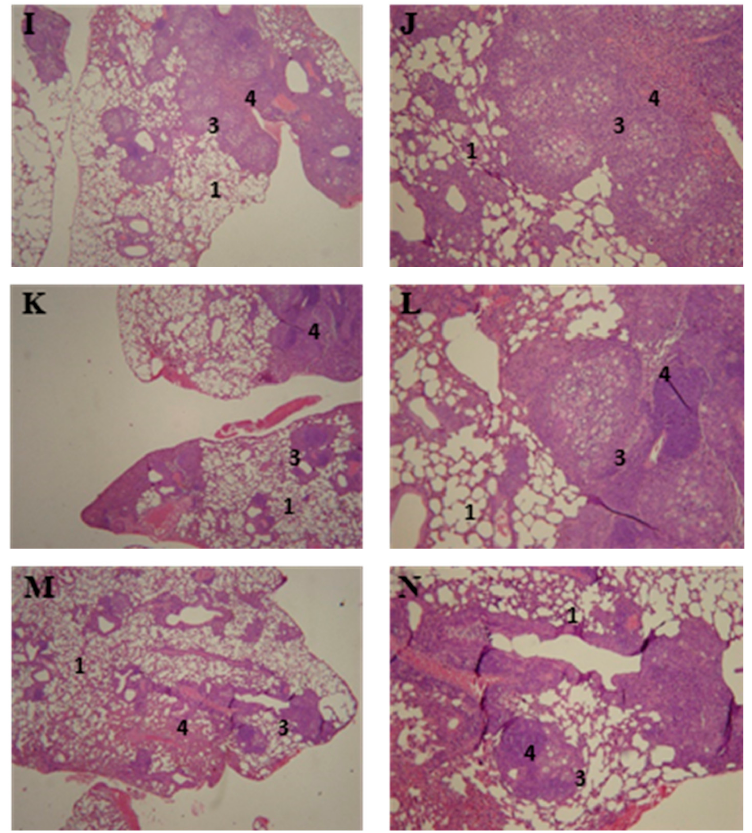
Figure 5. BALB/c mice lung histology (HE-stain) after 51 days of infection with P. brasiliensis. Findings include; (1) preserved lung tissue, (2) loose granulomas, (3) well defined granulomas and (4) presence of inflammatory infiltrates. Figures depict ( A , B ) non-infected mice and: infected and ( C , D ) non-treated, ( E , F ) treated with empty nanoparticles and 20 µ g of free form of P10, ( G , H ) treated with empty nanoparticles and treated with P10-complexed nanoparticles with ( I , J ) 1 µ g of P10, ( K , L ) 5 µ g of P10 and ( M , N ) 20 µ g of P10. ( A , C , E , G , I , K , M ) bear 8 × magnification; ( B , D , F , H , J , L , N ) bear 20 ×